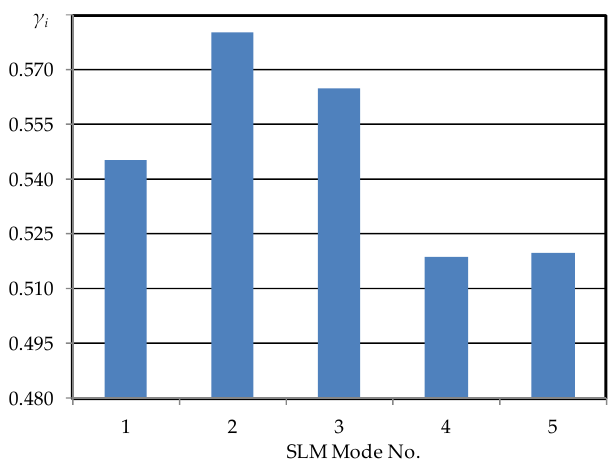
Figure 9. The resulting relational quality assessments of SLM technological modes.